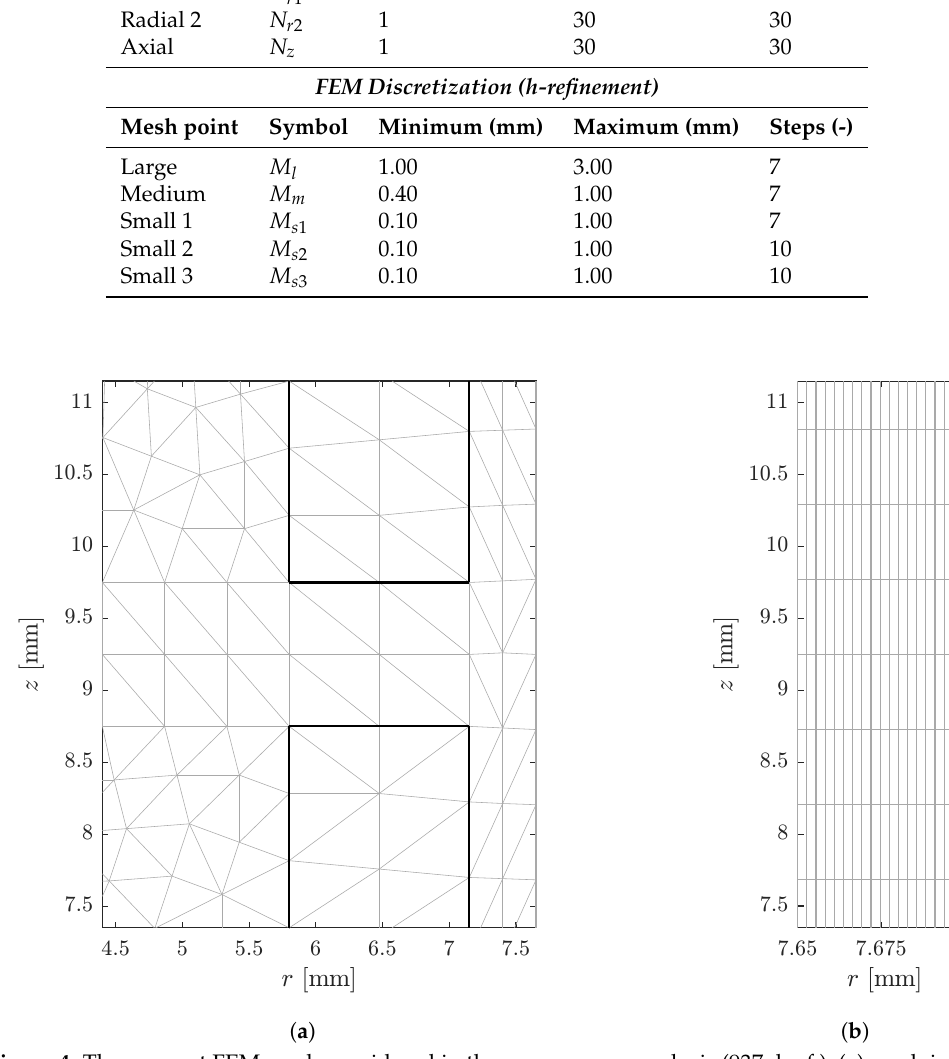
Figure 4. The coarsest FEM mesh considered in the convergence analysis (937 d.o.f.); ( a ) mesh in the non-conductive region ( b ) mesh in the conductive region near the outer